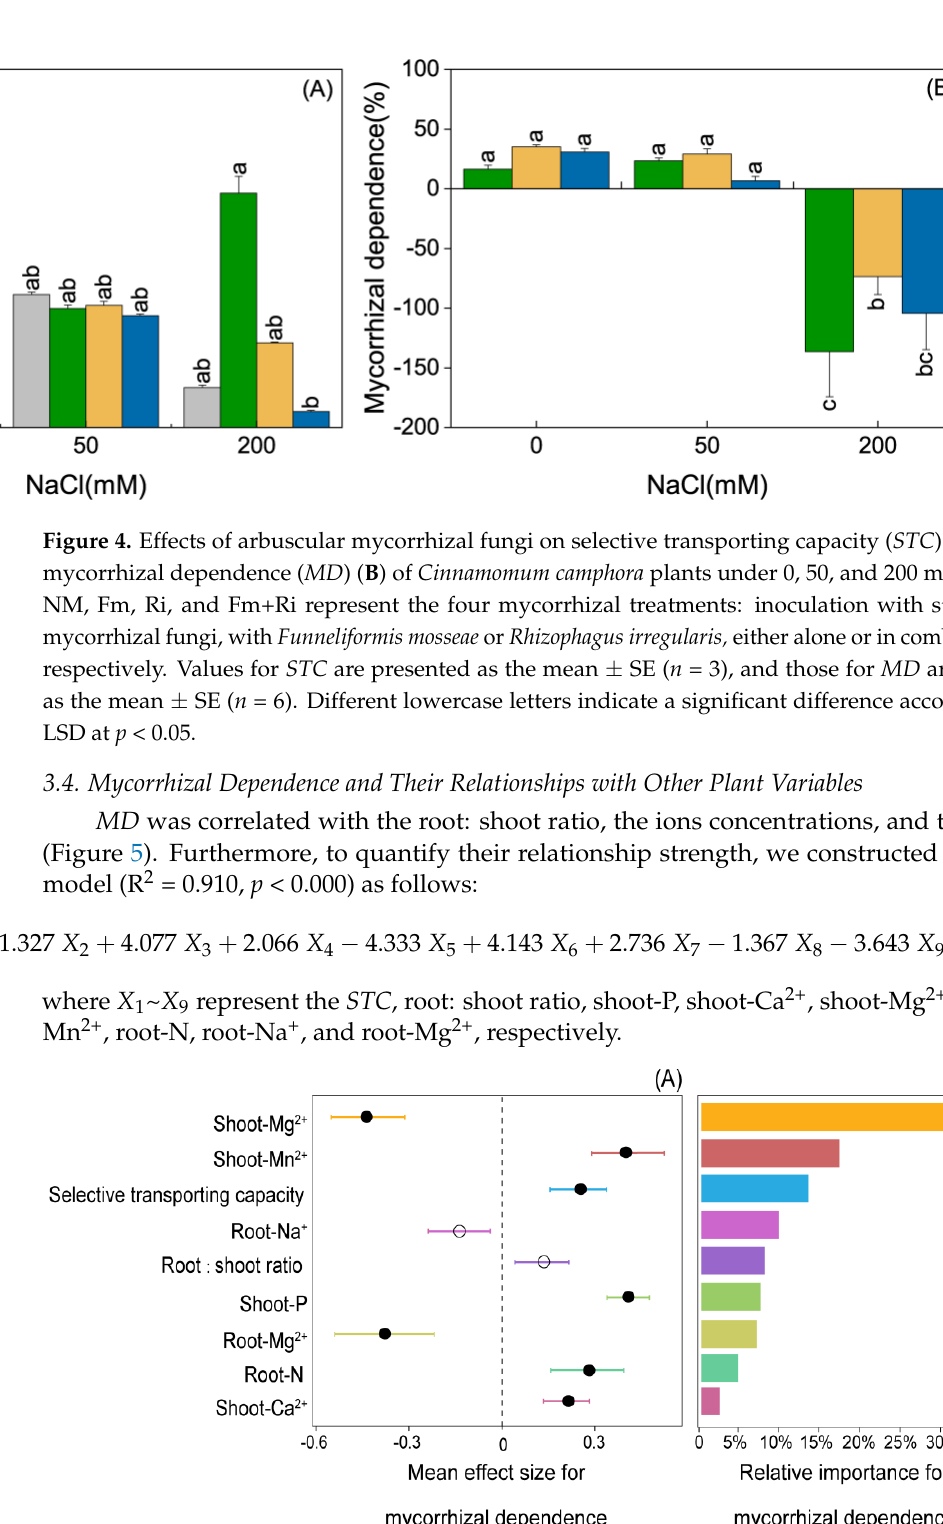
7 of 14 Figure 3. Effects of arbuscular mycorrhizal fungi on Mg 2+ :Na + ratio ( A ), K + :Na + ratio ( B ), Ca 2+ :Na + ratio ( C ) in shoots and roots, and shoot:root ratio of Na + ( D ) of Cinnamomum camphora plants under 0, 50, and 200 mM NaCl. NM, Fm, Ri, and Fm+Ri represent the four mycorrhizal treatments: inoculation with sterilized mycorrhizal fungi, with Funneliformis mosseae or Rhizophagus irregularis, either alone or in combination, respectively. Values are presented as the mean ± SE ( n = 3). Different lowercase letters indicate a significant difference for means of either root or shoot according to LSD at p < 0.05. 3.3. Mycorrhizal Dependence and Selective Transporting Capacity The STC of plants decreased as salinity increased, however the opposite trend was observed for F. mosseae − inoculated plants (Figure 4A). The STC of mycorrhizal plants inoculated with single AM fungus was more than that of NM plants under the harshest